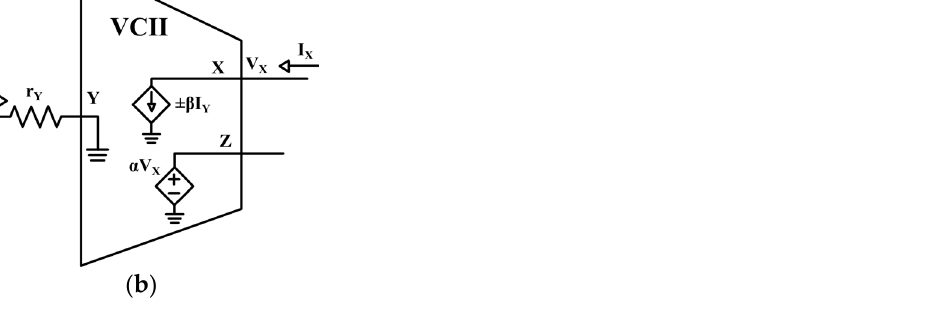
Figure 1. VCII with electronic tunable impedance at the Y port: ( a ) symbolic representation; ( b ) in- ternal structure.